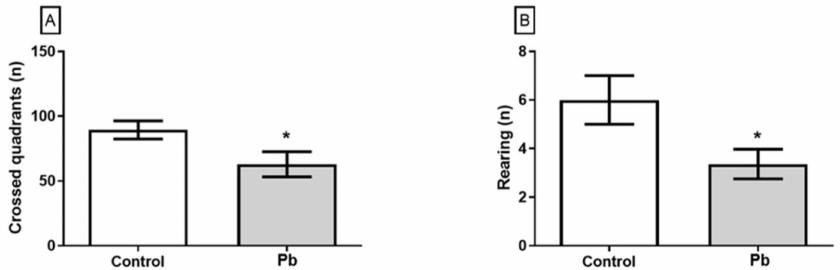
Figure 2. E ff ect of the long-term exposure of young Wistar rats to 50 mg / Kg of Pb on the exploratory activity in the open field test. In ( A ) crossed quadrants and ( B ) ‘rearing’. The results are expressed as mean ± standard error. * Student t test, p < 0.05.